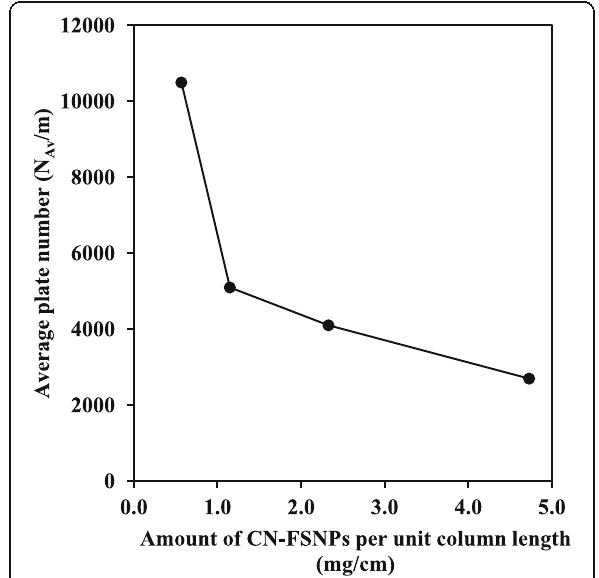
Fig. 6 Average plate number for DMF, formamide, and thiourea obtained on poly(GMM-co-EDMA) monolithic column with varied amounts of incorporated CN-FSNPs. Separation conditions: column, 10 cm × 4.6 mm i.d.; mobile phase, 95% ACN (v/v), 5% water (v/v); detection, UV at 214 nm; flow rate, 1 mL/min; injection volume, 20 μ L; column temperature, room